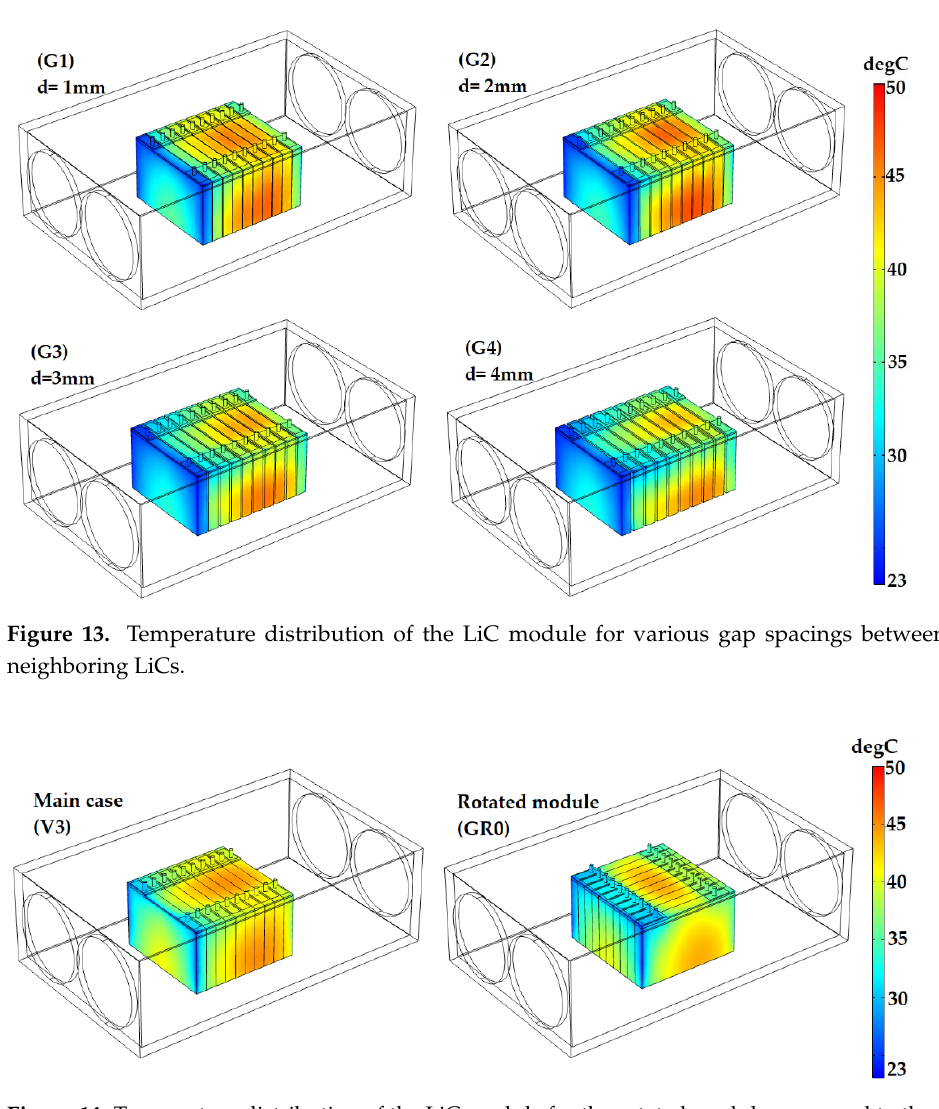
Figure 14. Temperature distribution of the LiC module for the rotated module compared to the main case study.